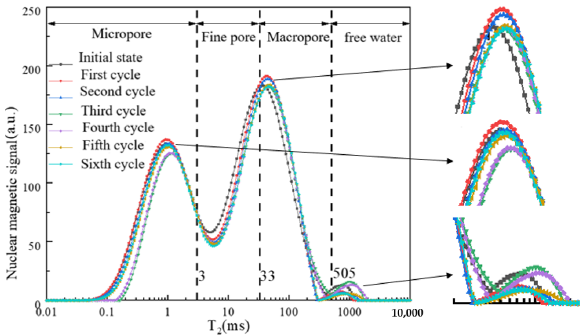
Figure 4. T 2 distribution before and after freeze–thaw cycles.